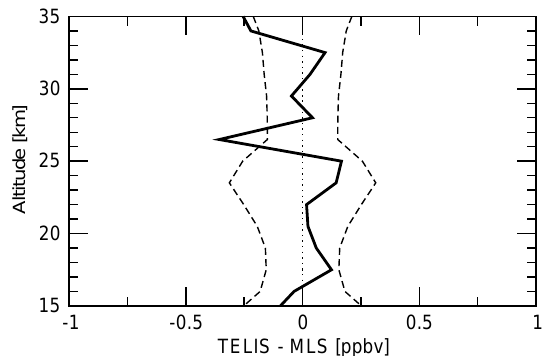
Fig. 9. The individual estimates of systematic effects in the ClO profile. Several systematic error sources have been grouped to- gether. In black the spectroscopic error is given for uncertainties in the spectral widths and line strengths of the HCl lines. In red the systematic errors due to various instrumental uncertainties are shown; the solid red line combines the systematic errors due to un- certainties in field of view, local oscillator frequency, instrumental line shape, and sideband ratio, the dotted red line refers to the ab- solute pointing, and the dashed red line to the non-linearity of the detector response function. In blue the systematic error due to the radiometric calibration is given and in turquoise the systematic er- ror by uncertainties in the atmospheric condition (temperature and pressure profiles). The thick black line is the RSS of these errors.